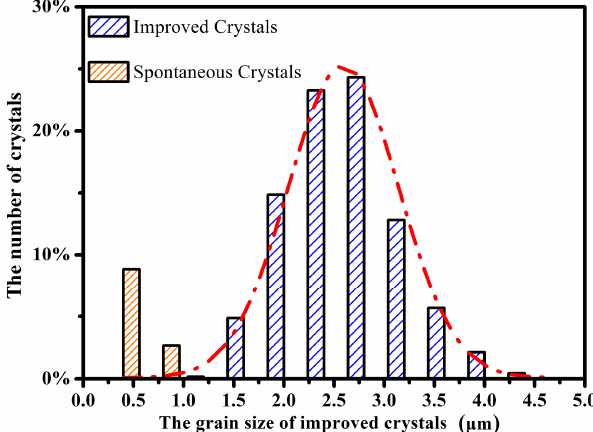
Figure 7. The grain size and size distribution of the improved diamond powders grown under the preferred deposition conditions at a growth duration of 90 min.